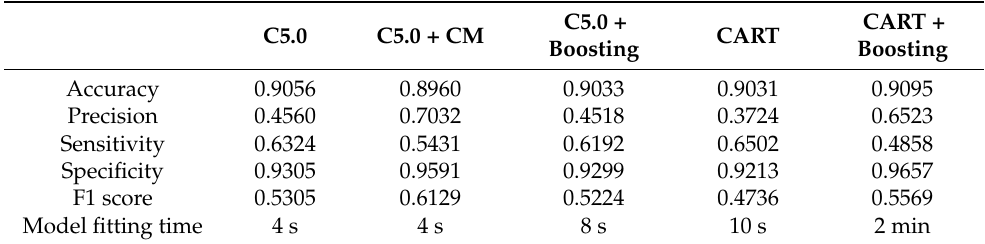
Table 14. Positive = yes confusion matrix evaluation